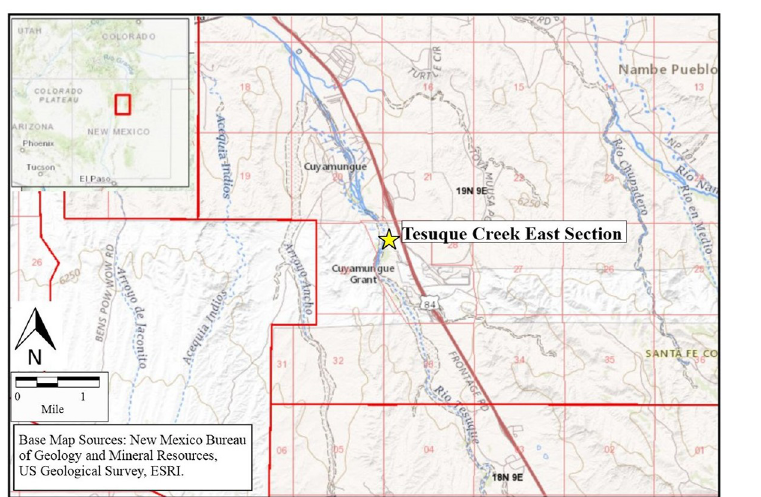
Fig 1. Map of the location of the Tesuque Creek East